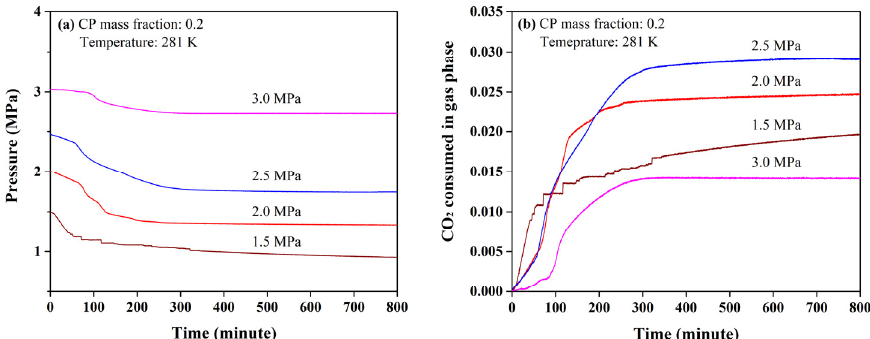
Figure 3. Pressure ( a ) and CO 2 consumption ( b ) profiles in the formation of mixed cyclopentane (CP)-CO 2 hydrates.